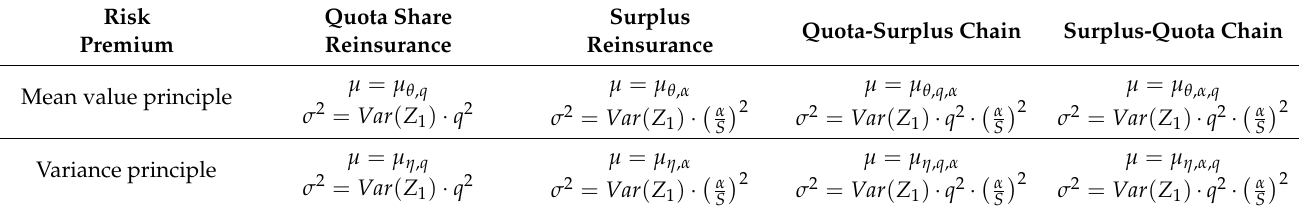
Table 5. The parameters of the insurer’s random variable Z 1 .